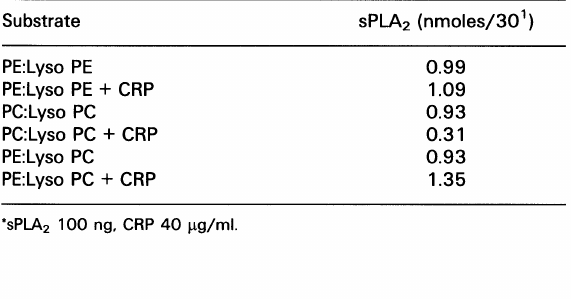
Table 1. Impact of substrate on inhibitory activity of CRP